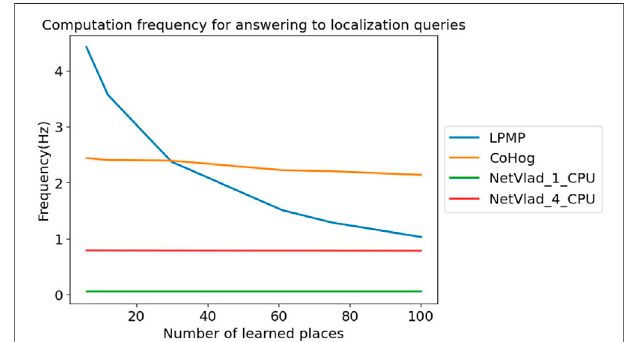
FIGURE 10 | Frequency achieved for answering localization queries. This graph presents the frequency at which Log-Polar Max-Pi (LPMP), CoHog, and NetVLAD answered localization queries depending on the number of locations learned at an equal place sampling rate on the boulevard